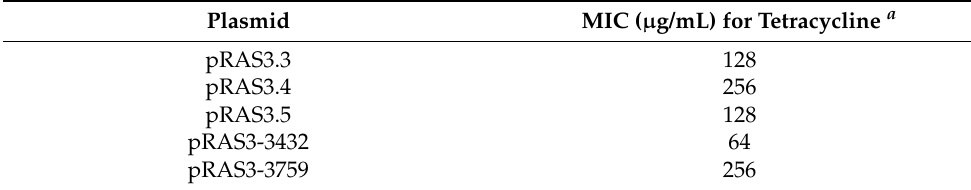
Table 3. Tetracycline resistance induced by pRAS3 plasmids in E. coli.